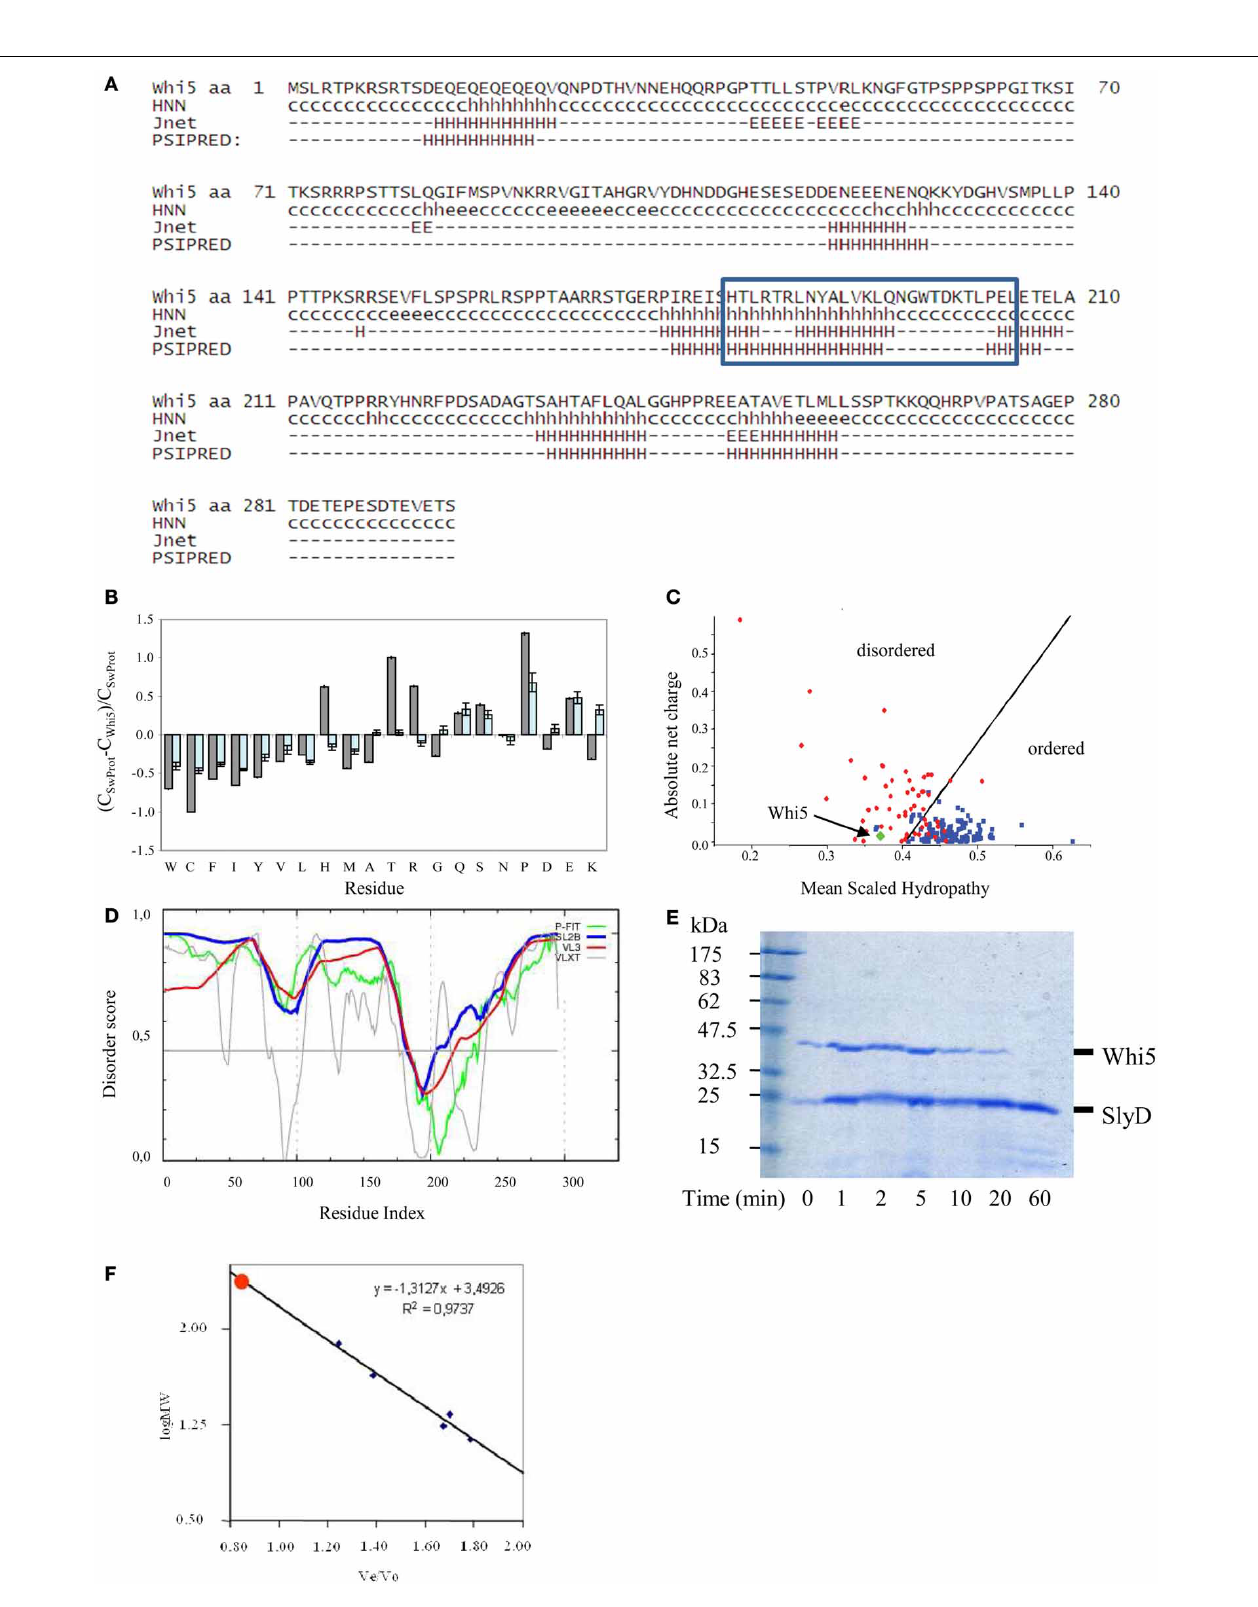
FIGURE 1 | Compositional and sequence analysis of Whi5 Sc . (A) Secondary structure prediction for Whi5 Sc . A simplified output of Proteus 2.0 shows only secondary structure elements predicted with confidence ≥ 5, in the range 0–9. The blue box corresponds to the Pfam “Whi5 domain”